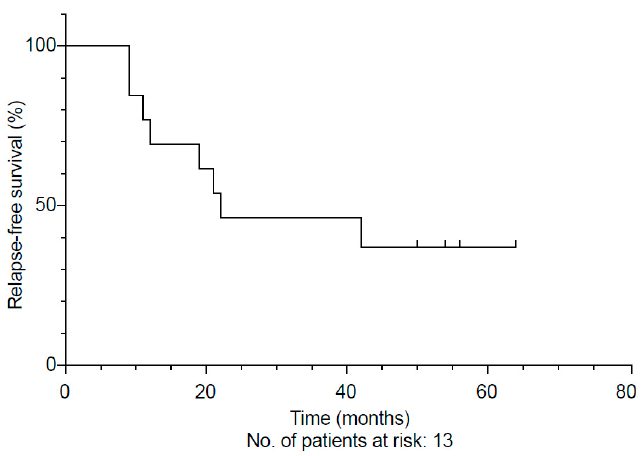
Figure 2. Onset of clinical relapse in 13 patients treated with rituximab (RTX), displayed as a Kaplan–Meier curve.